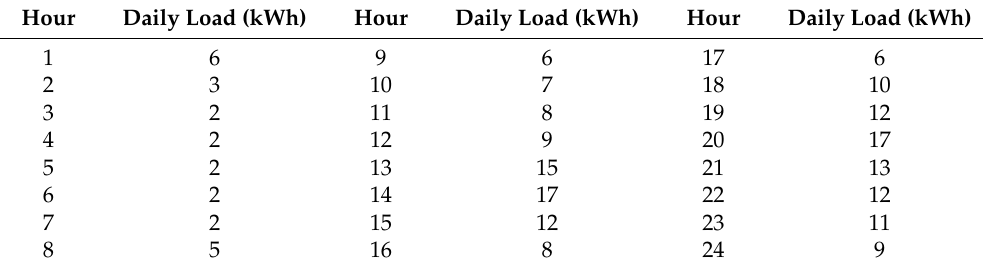
Table 4. Case study 2: Fixed daily load